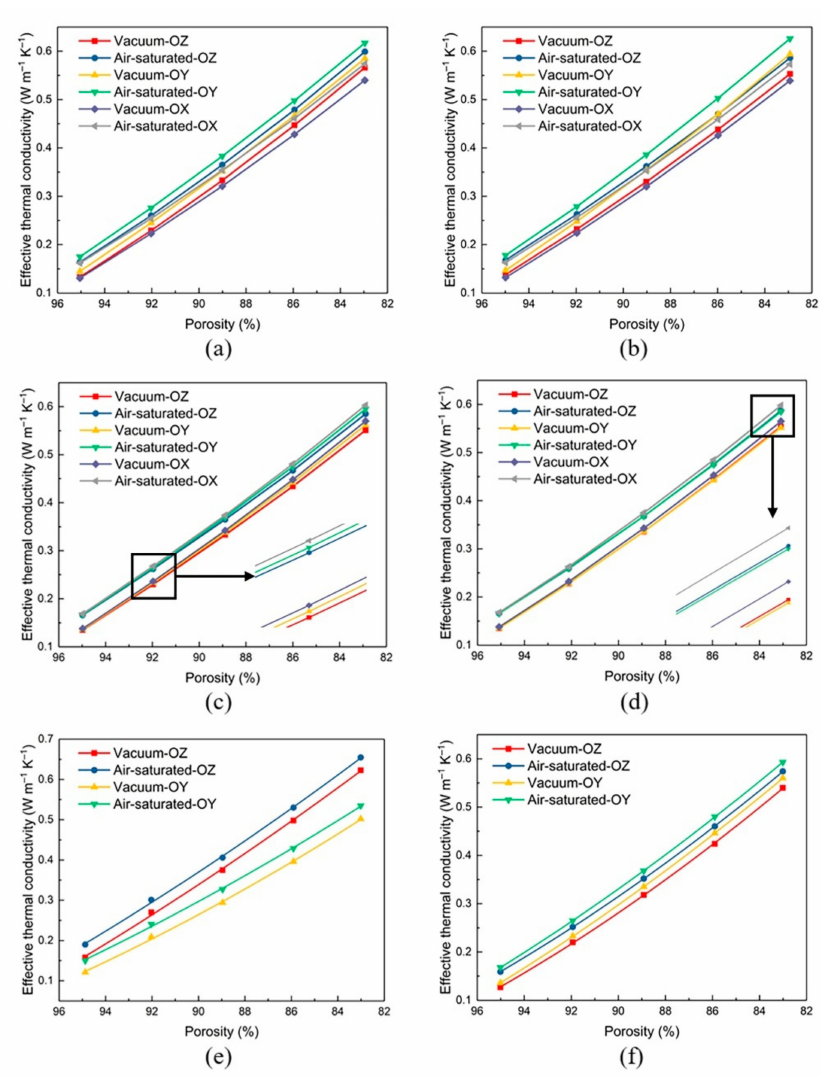
Figure 9. Effective thermal conductivity of various cellular structures in different orientations: ( a ) RV10; ( b ) RV30; ( c ) RV50; ( d ) RV70; ( e ) KT; ( f )